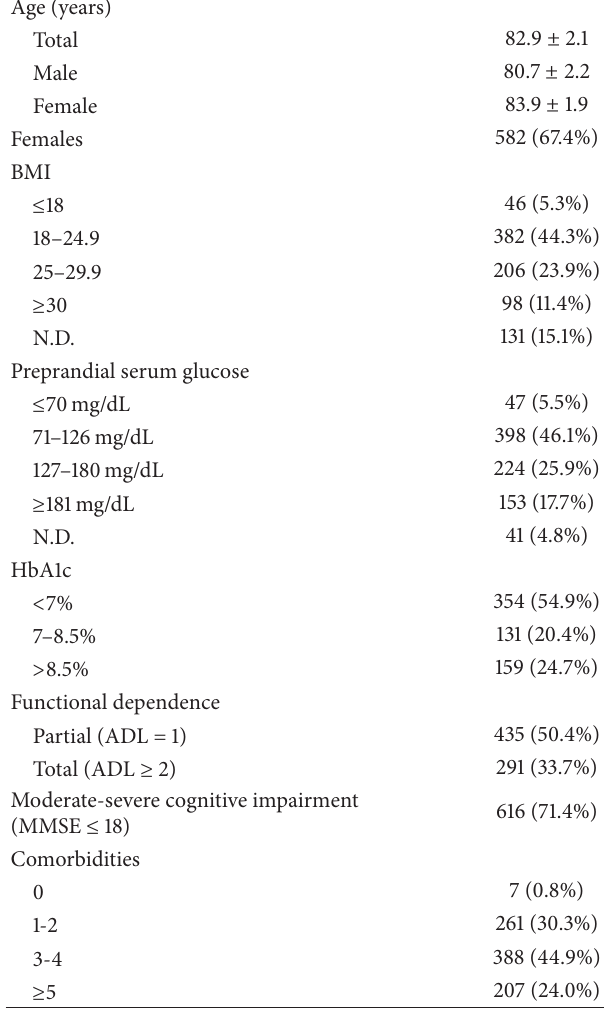
Table 1: Characteristics of diabetic patients living in long-term